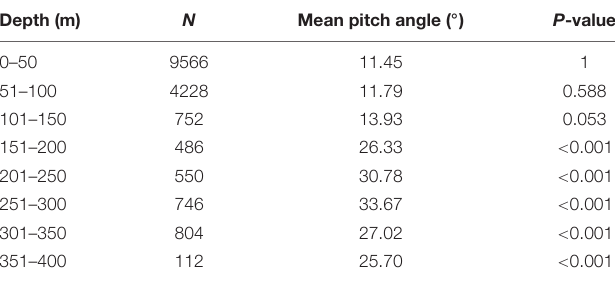
TABLE 3 | Summary of two-sample t -test scores comparing surface fast-start pitch angles ( < 50 m) to fast-start pitch angles at depths exceeding 50 m. Depth (m) N Mean pitch angle ( ◦ ) P -value